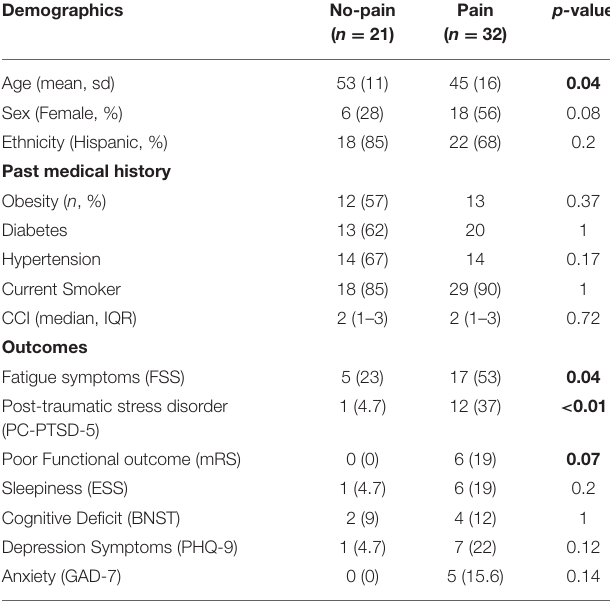
TABLE 4 | Clinical variables and outcomes across pain and